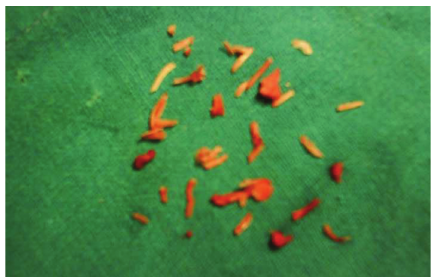
Figure 3: Bony fragments removed from the